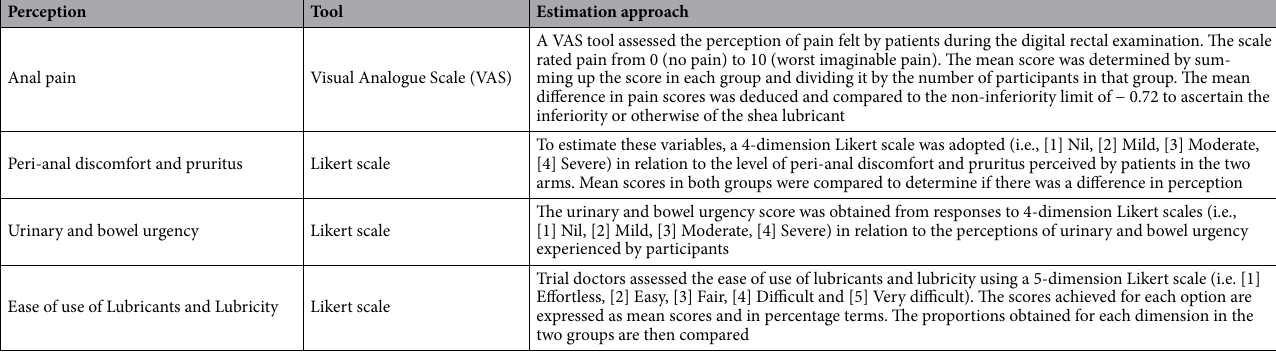
Table 1. Summary of analyses of patients’